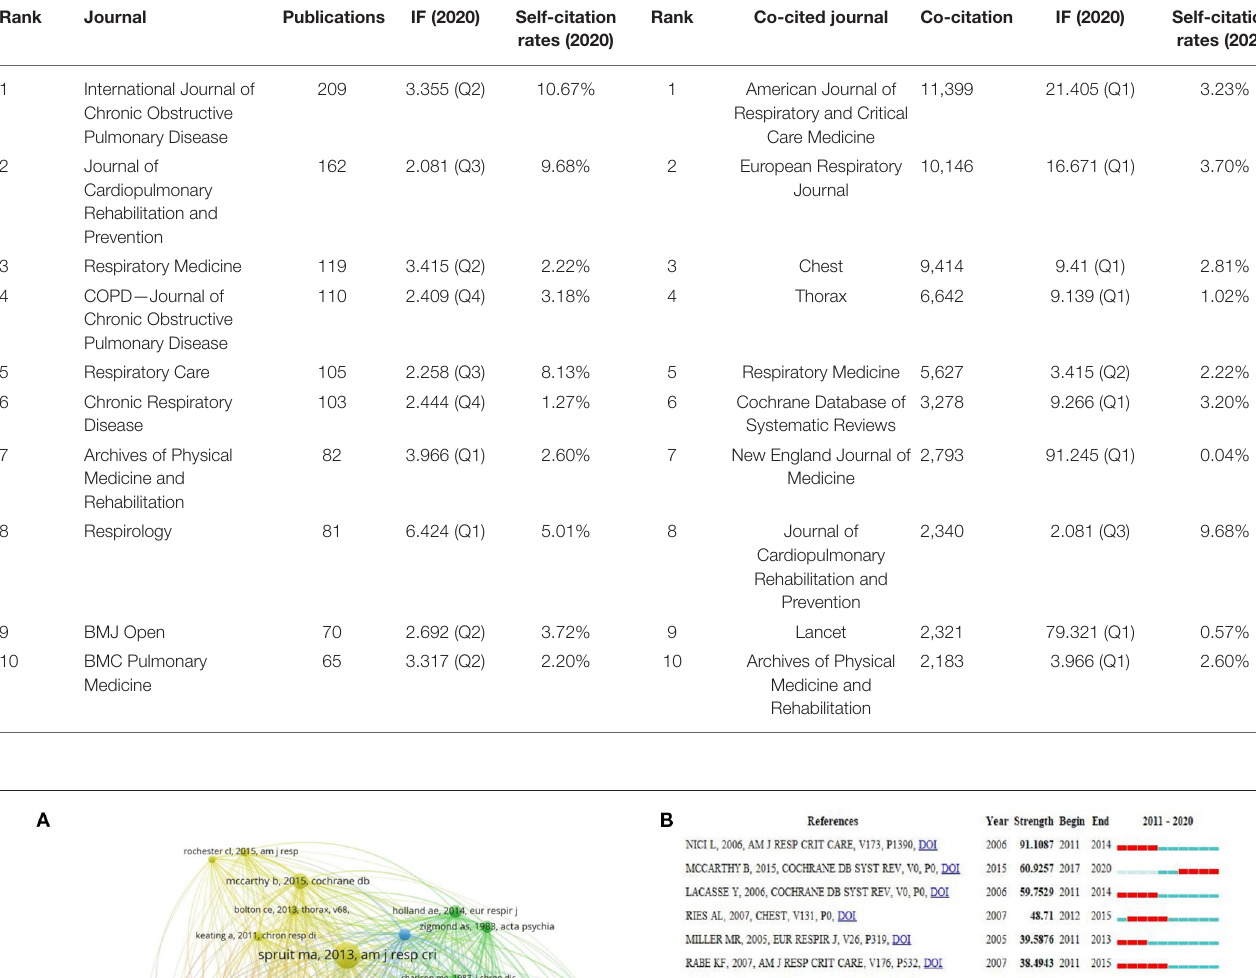
TABLE 4 | Top 10 scholarly journals and co-cited journals related to research on pulmonary rehabilitation.